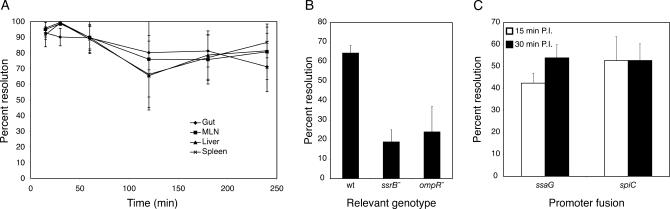
Kinetics of SPI-2 Expression during Murine Typhoid(A) Mice were infected with the wild-type PsseA RIVET strain (NB25) as described in Materials and Methods. At the indicated times following inoculation, the ileal loops, mesenteric lymph nodes, spleen, and liver were taken and assessed for expression from PsseA by determining the percent resolution. The results shown are the mean ± standard error of the mean from three independent experiments.(B) Mice were infected with the wild-type (NB25), ssrB
− (NB7), and ompR
− (NB15) PsseA RIVET strains, and at 15 min following inoculation, the ileal loop was removed and homogenized, and the percent resolution of the infecting Salmonella was determined.(C) Mice were infected with the wild-type PspiC (NB33) and PssaG (NB31) RIVET strains for 15 and 30 min, the ileum was removed and homogenized, and the percentage resolution determined. The results shown are the mean ± standard error of the mean for three independent experiments.